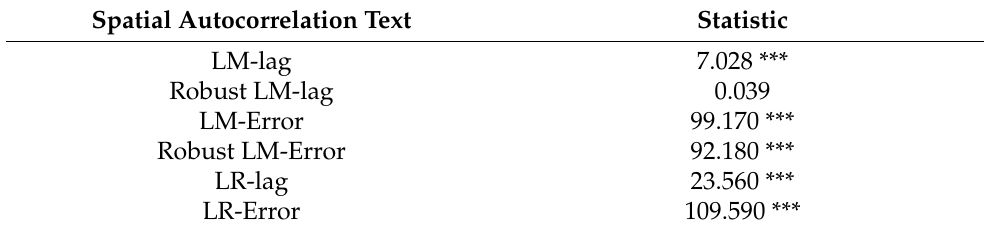
Table 6. Test results of the spatial econometric